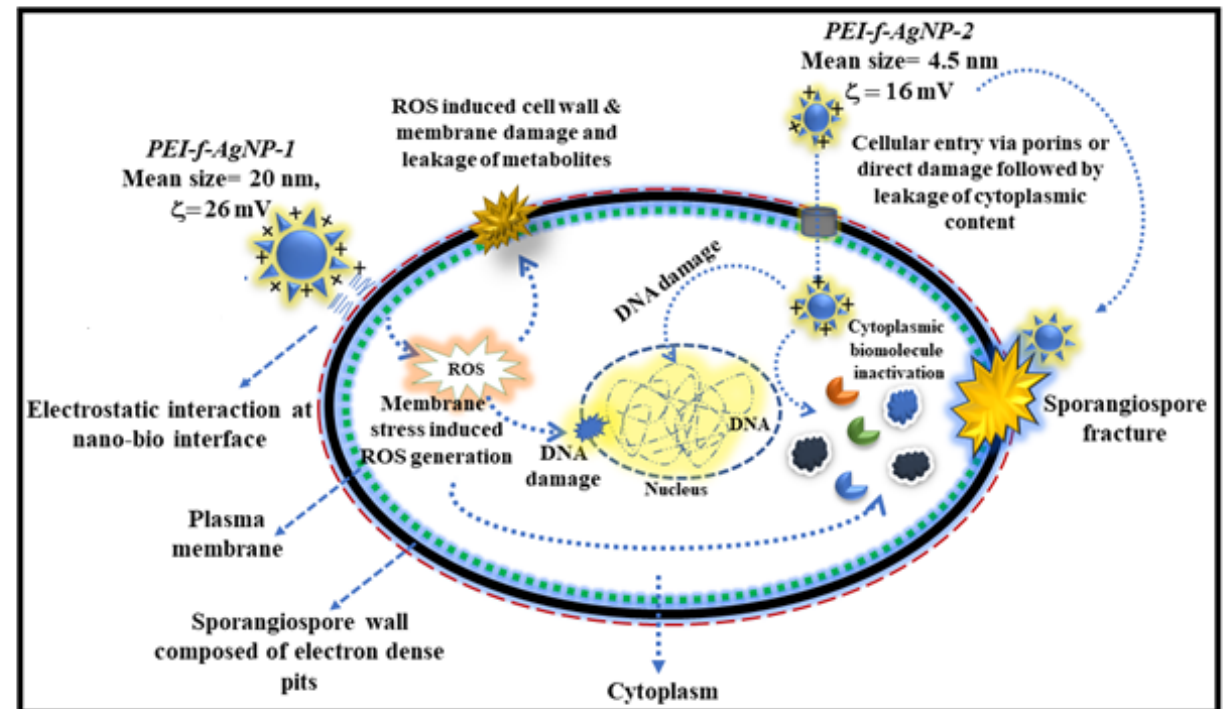
Figure 10. Diagrammatic representation of the possible mechanism of anti-sporangiospore activity of PEI-functionalized silver nanoparticles.